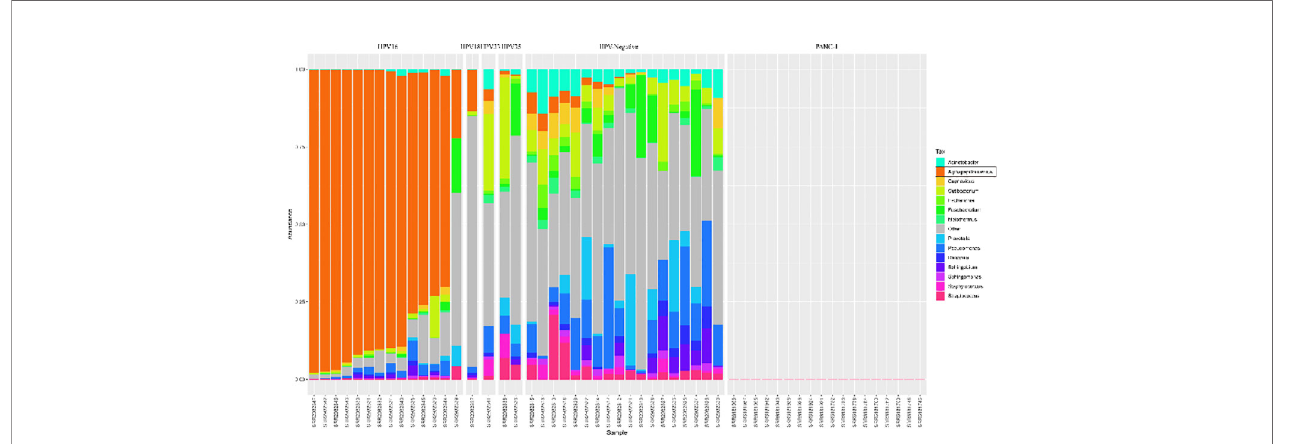
FIGURE 1 | Distribution of microbial relative abundances at the genus level in the Head and Neck cancer and Panc-1 cell line datasets. The hpv (human papillomavirus) status is labeled at the top. The samples are sorted by the relative abundance of genus Alphapapillomavirus , which is colored by orange. The top 14 abundant genera are presented, and the rest are classi fi ed as Others.